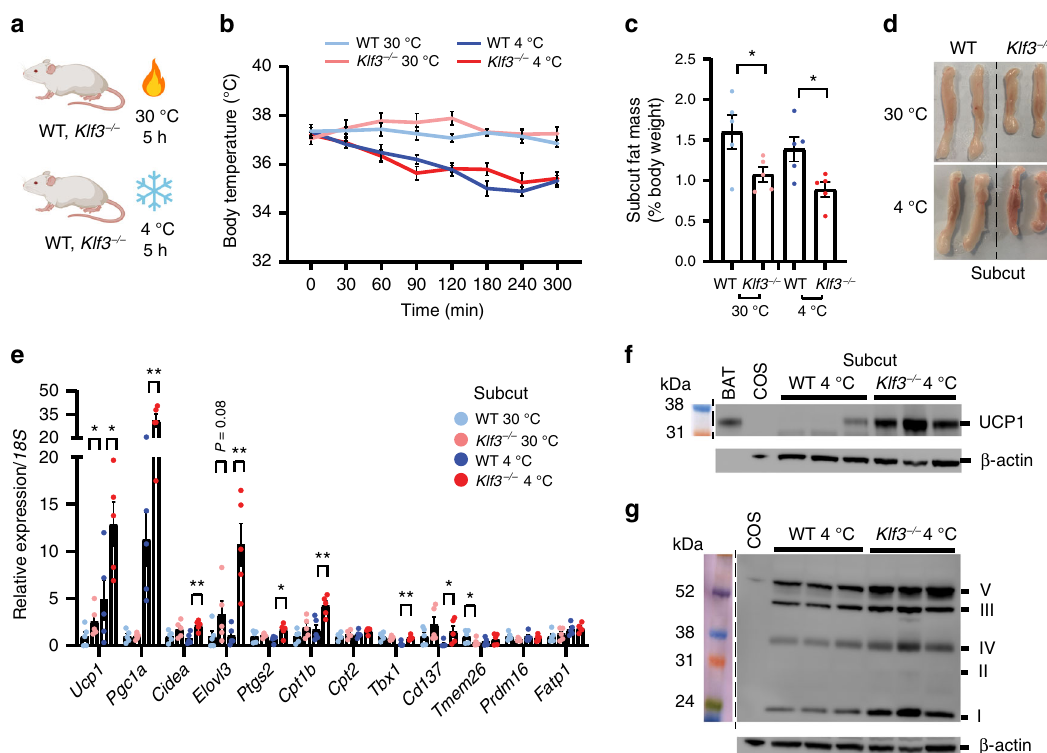
Fig. 2 KLF3 de fi ciency enhances the thermogenic response. a WT and Klf3 − / − mice were acutely housed at 30 °C or 4 °C (cartoon created with BioRender.com) and b body temperature was monitored by rectal probing over a 5 h period ( n = 5 mice). c Weights of WT and Klf3 − / − subcut AT from mice housed at 30 °C or 4 °C were recorded as relative to body weight ( n = 5 mice.) d Representative macroscopic images of subcut AT from WT